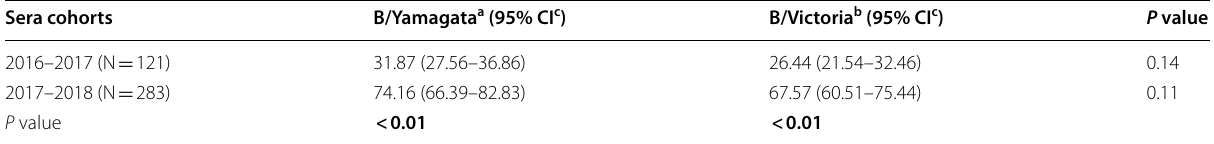
GMT was calculated based on the HI titer. P values were estimated using nonparametric tests and p values of 0.05 or less are shown in bold